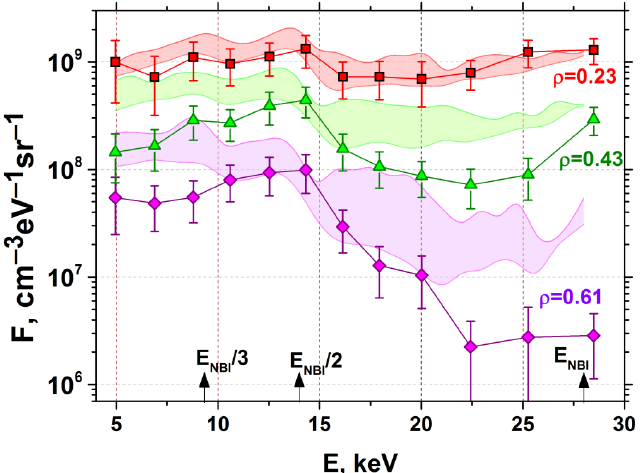
Figure 12. Fast ion energy distribution at different spatial locations obtained in the experiment using active NPA diagnostic (points and lines) and simulated using NUBEAM (filled areas). Error bars— sum of the epistemic and aleatoric (95% confidence interval) errors. The figure is taken from [30] and reproduced with permission from IOP